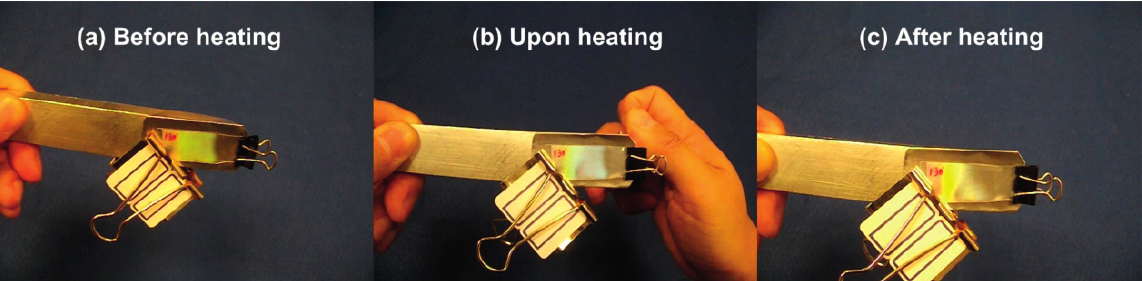
Figure 17. Heating to partial remove structural color in nano-imprinted PC